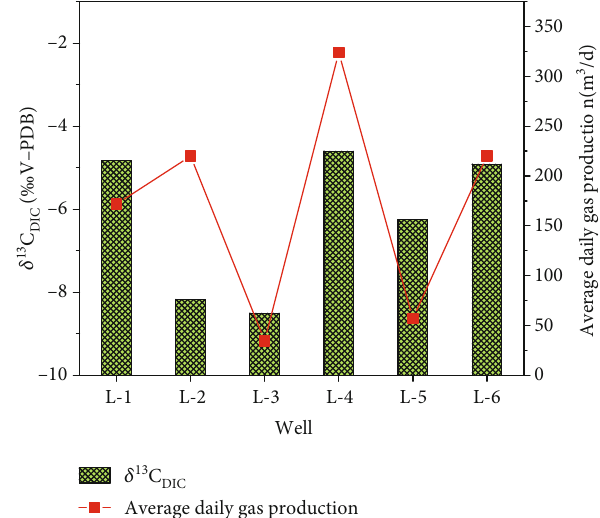
Figure 8: Relationship between dissolved inorganic carbon isotopes and gas